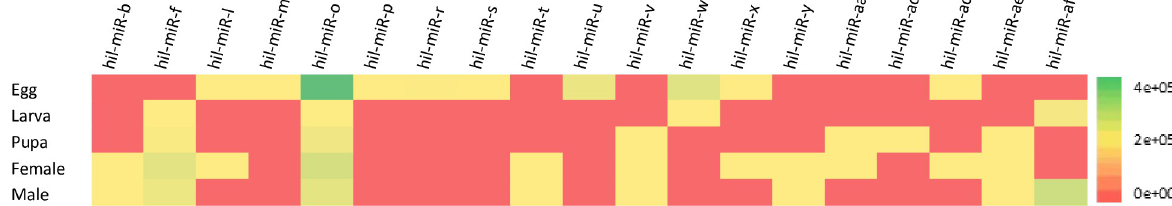
Fig 2. Heatmap of unique microRNA expression across life stages. Expression is based on average read count of triplicate samples for each life stage.